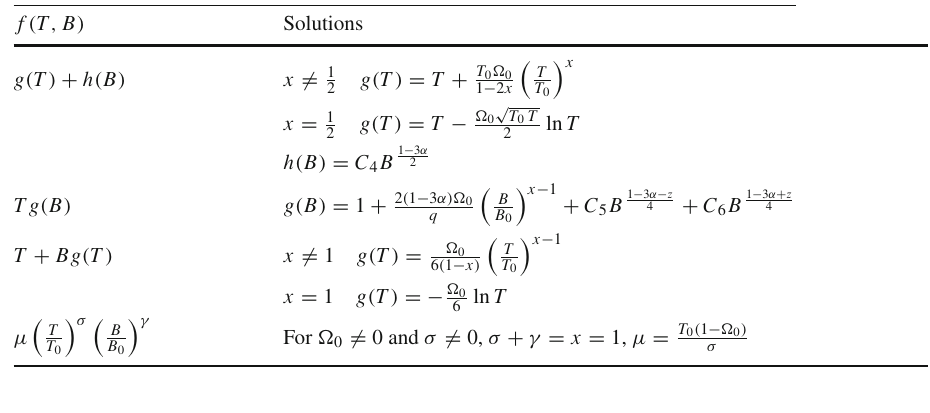
constraints whenever the reconstructed superbounce f ( T , B ) Lagrangian is able to realise vacuum solutions. Overall, all models are able to generate such solutions while also hosting the